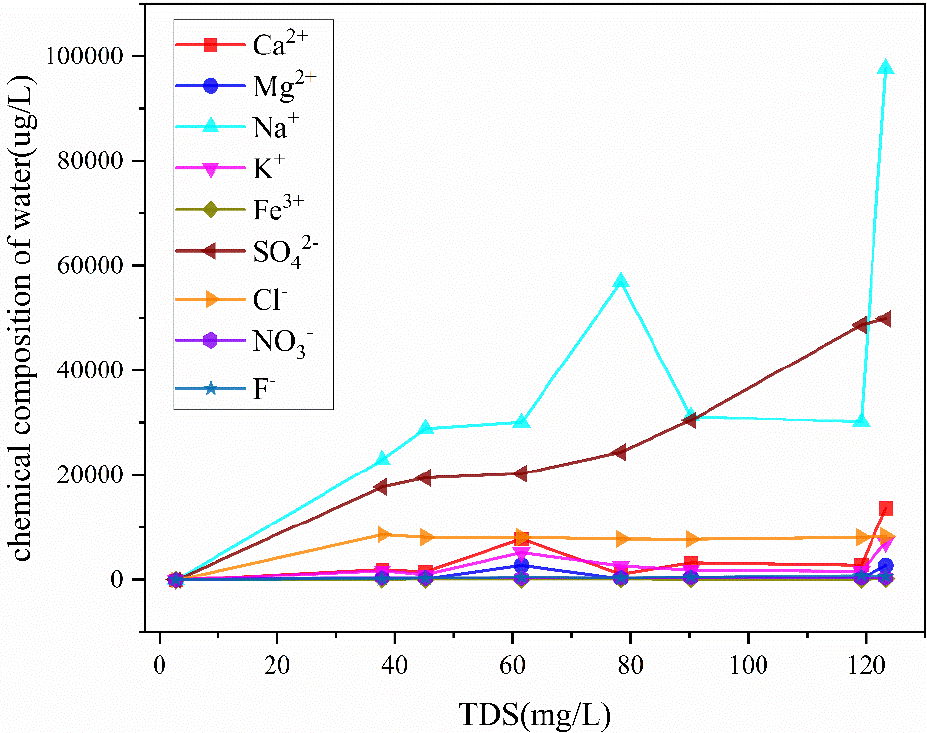
Figure 7. Plot of the hydro-chemical components of the FGU immersion solution change with TDS. is − 0.843, indicating that the dissolution of sulfate minerals has a negative effect on the increase of TDS and has a great influence. TDS is negatively correlated with sodium ions, and sodium ions are positively correlated with sulfate ions, indicating that mirabilite dissolution exists, but mirabilite dissolution is weak and has a negative effect on TDS increase. The strong correlation between TDS and Ca 2+ indicates that calcium concentration plays a key role in the change of TDS. The reasons for the change were analyzed as follows: the initial calcium ions concentration of the water sample was large, and calcium ions were absorbed by clay minerals in the initial stage of soaking. In addition, according to the common ion effect, the dissolution amount of gypsum in FGK1 water was small or insoluble, and the calcium ions concentration in the water decreased, and TDS decreased accordingly.